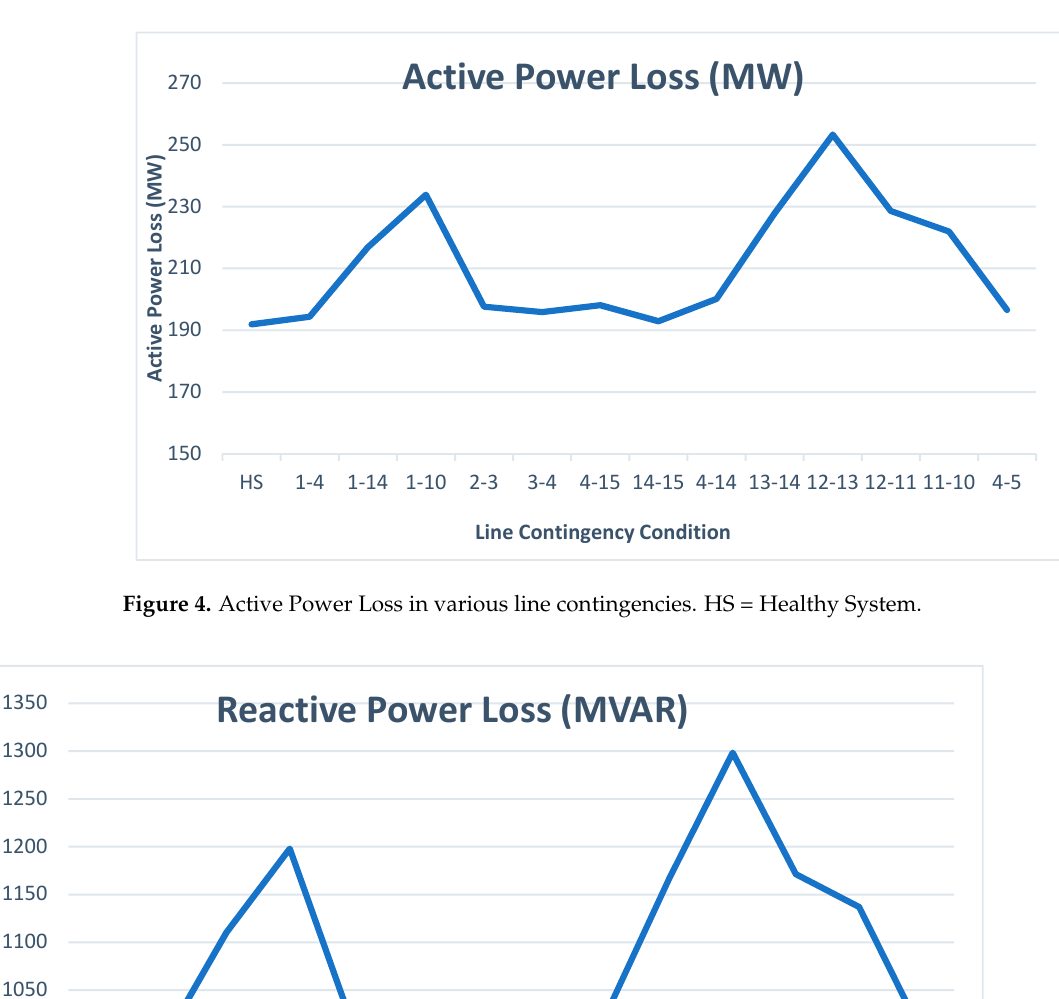
Figure 6. Security Margin of Indian 62 Bus system for various contingencies. HS = Healthy System.